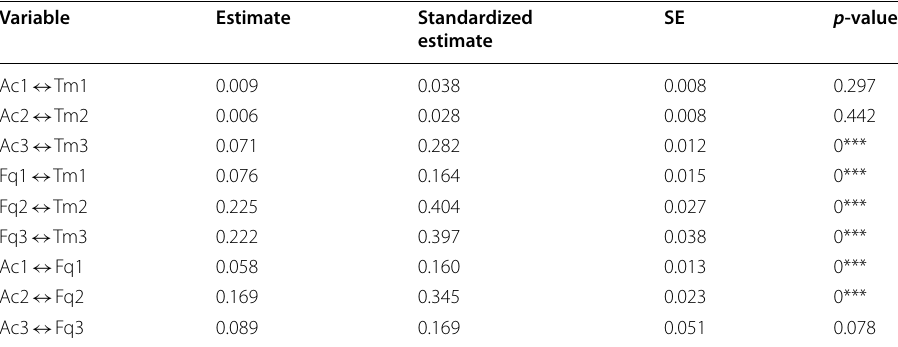
Table 7 Extra dependencies in the CFA model